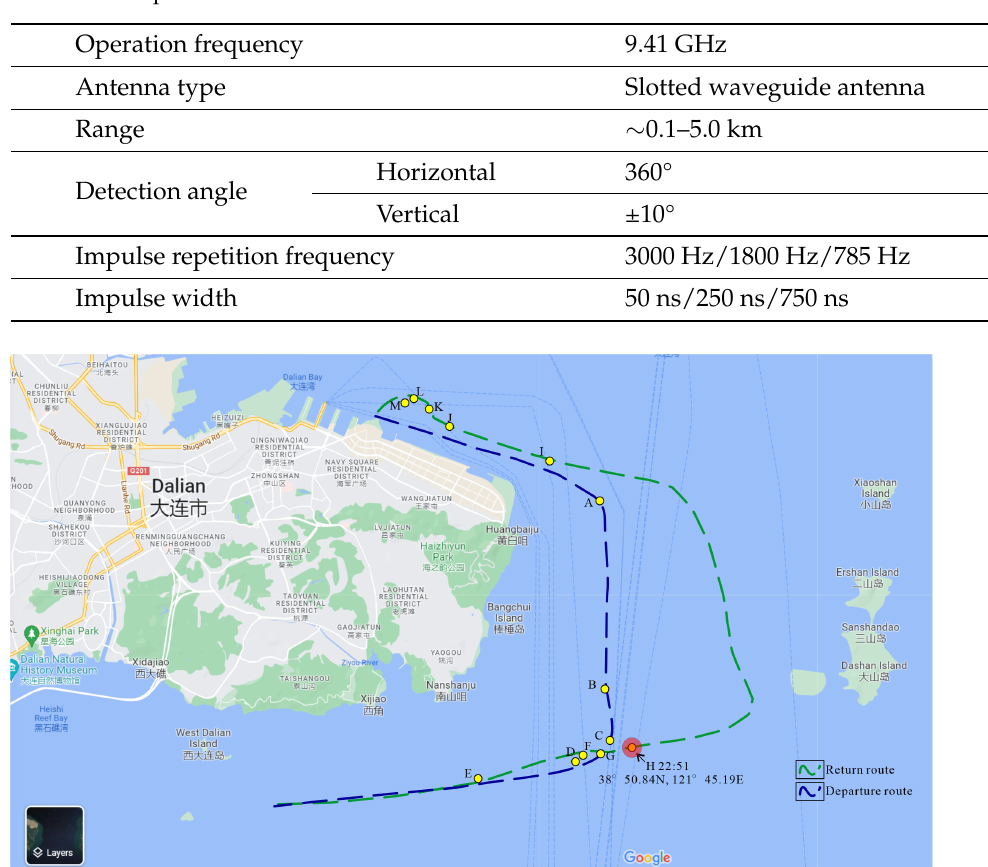
Figure 6. Navigation route of ship “YUKUN”. Oil spill sampling points are marked in